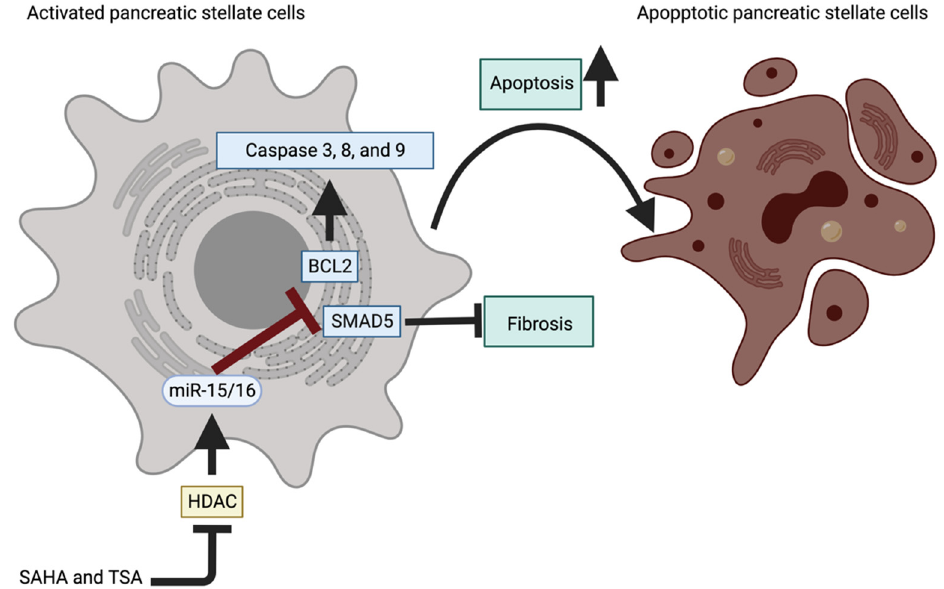
Figure 5. HDAC/miR-15/16 axis regulates the activation of PSCs in CP (please see text for details). Created with BioRender.com.